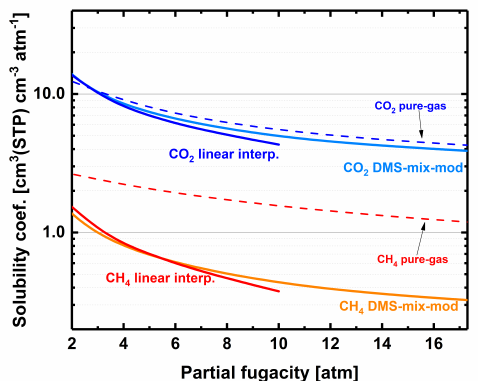
Figure 8. CH 4 and CO 2 pure- and mixed-gas solubility coefficients (6FDA-mPDA) vs. partial fugacities. The mixed-gas solubility coefficient curves for methane and carbon dioxide were obtained by linear interpolations of mixed-gas experimental data or by fitting with a modified version of the DMS model for gas mixtures (DMS-mix-mod)—more details can be found in the Supporting Information of this work (Figure S4 and Figure